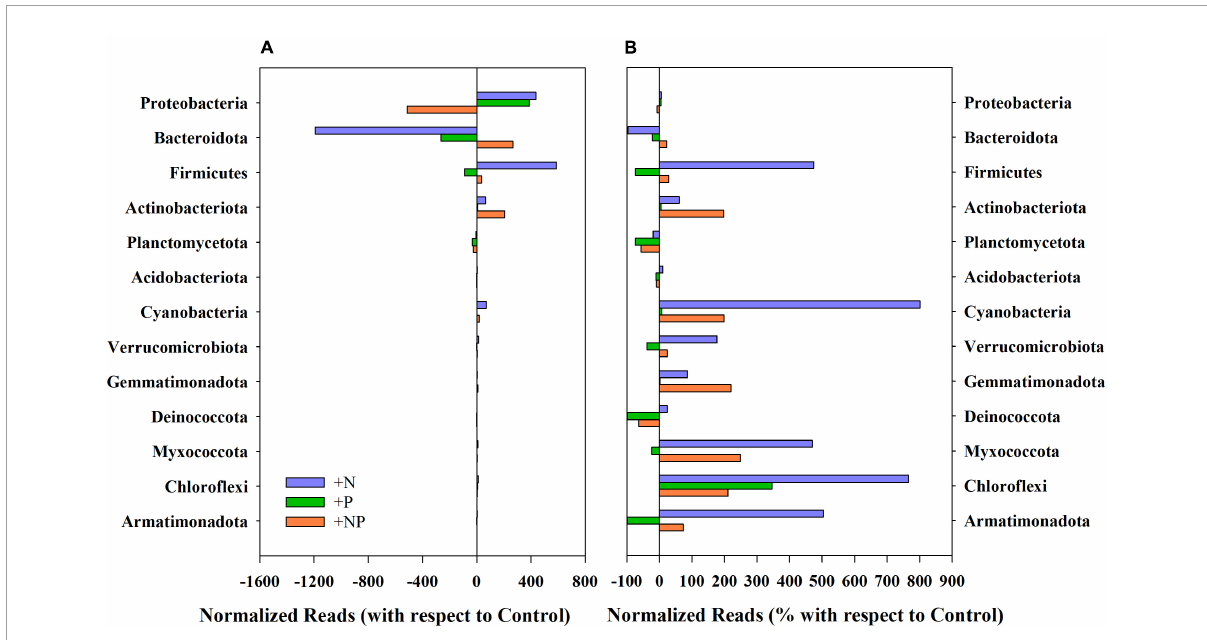
FIGURE2 (A) Variation of the normalised reads in the different nutrient amendment treatments with respect to the control for the main phyla present in the studied microbial mat. (B) Percentage of variation of the normalised reads in the different nutrient amendment treatments with respect to the control for the main phyla present in the studied microbial